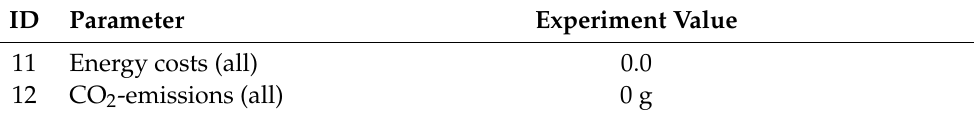
Table A15. Experiment